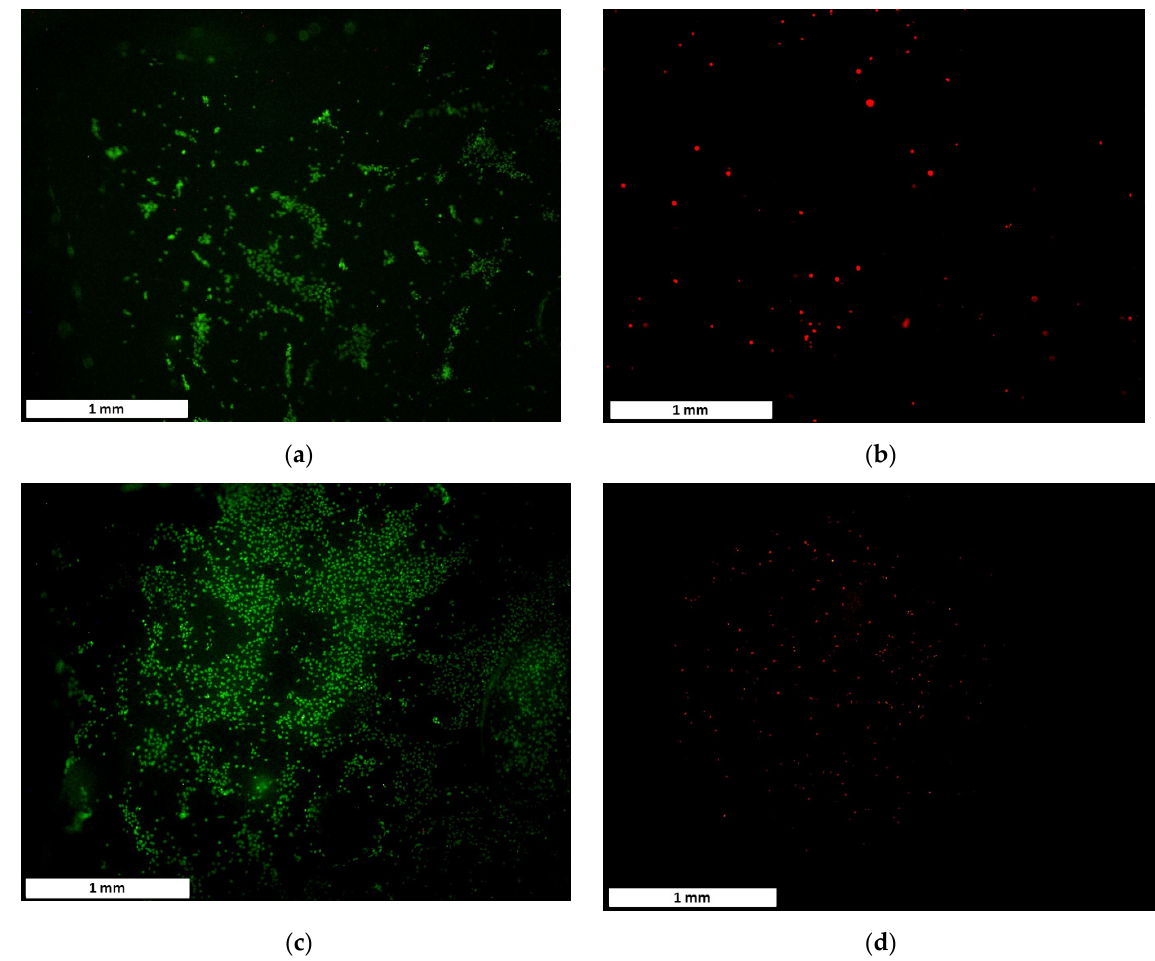
Figure 5. The effect of BaSO 4 coating on the endothelial cell (HUVEC) functions—without BaSO 4 coating ( a ) adhered cells on the PCL tile, ( b ) proliferated cells on the PCL tile; and with 30% BaSO 4 and 10% PCL coating ( c ) adhered cells on the PCL tile and ( d ) proliferated cells on the PCL tile.